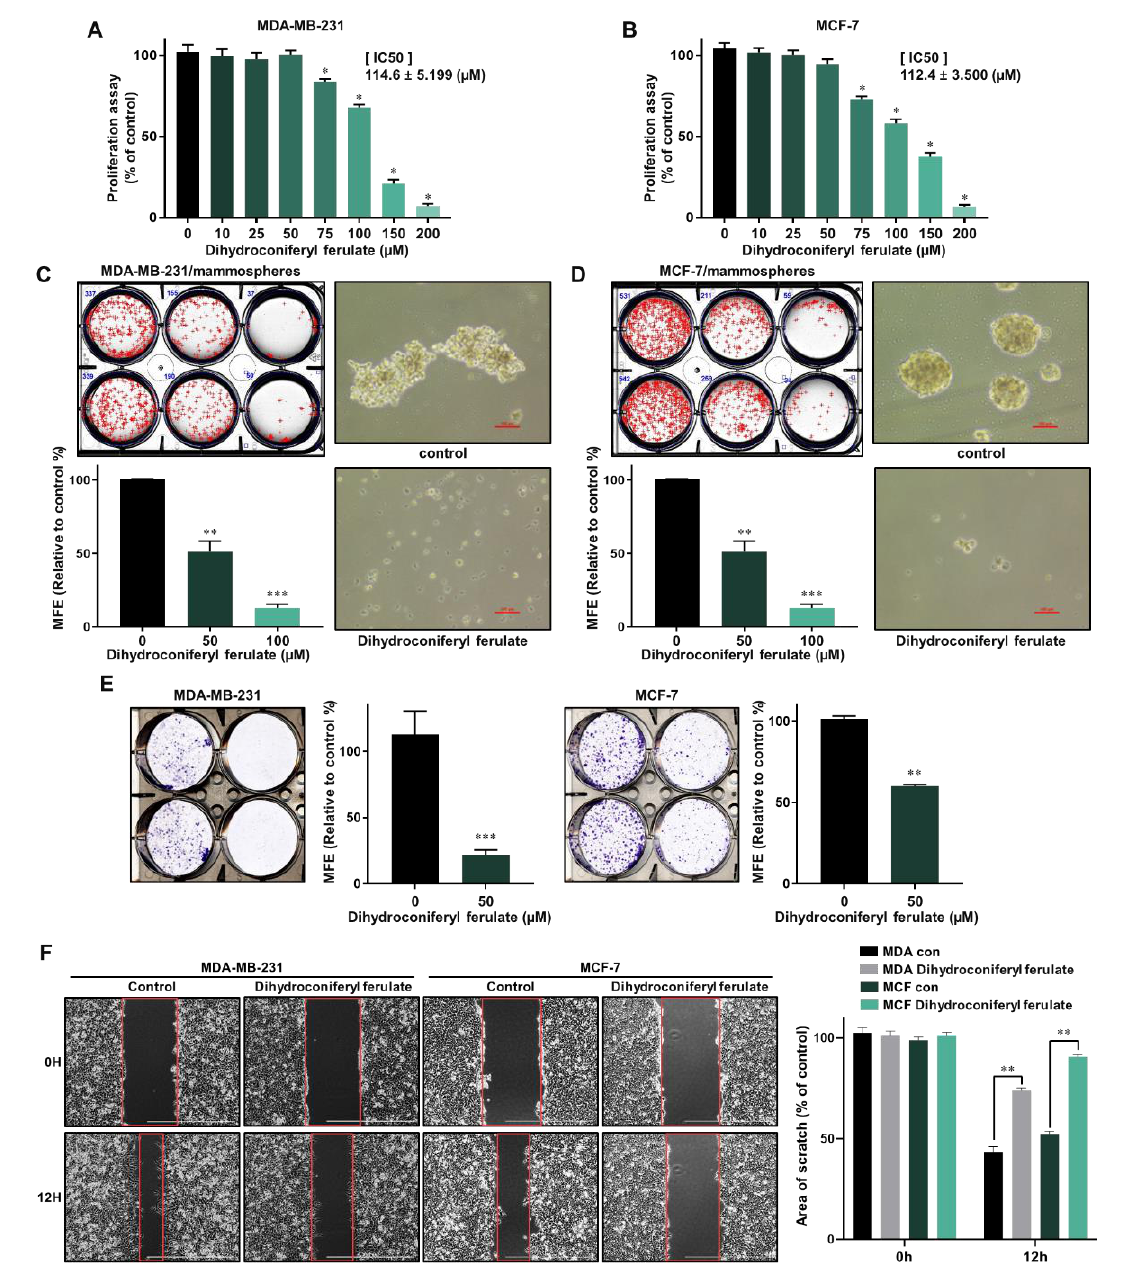
Figure 3. Inhibitory effects of dihydroconiferyl ferulate on cancer cell proliferation and formation of mammospheres. ( A , B ) The antiproliferative ability of dihydroconiferyl ferulate was determined using a proliferation assay kit with MDA-MB-231 and MCF-7 cells treated with dihydroconiferyl ferulate. * IC50 value is the drug concentration required for 50% growth reduction in the survival curve. ( C , D ) To measure the effect of dihydroconiferyl ferulate on the formation of mammospheres derived from breast cancer cells, they were cultured with increasing concentrations of dihydroconiferyl ferulate. After 7 days, the mammosphere morphologies were analyzed. Representative tumorsphere images were examined via inverted microscopy at 10× magnification (scale bar = 100 µm). ( E , F ) Effects of dihydroconiferyl ferulate on colony formation and migration of breast cancer cells. MDA-MB-231 and MCF-7 cells (1 × 10 3 per well) were cultured with or without dihydroconiferyl ferulate for 7 days. The colonies were scanned using a scanner. Migration images for dihydroconiferyl ferulate were captured at 12 h (scale bar: 1000 µm). The percent inhibition of cancer cell migration was determined relative to the untreated control, which was designated 100. Representative data were collected and represent the mean ± standard deviation; ** p < 0.01, *** p < 0.001 vs. control .